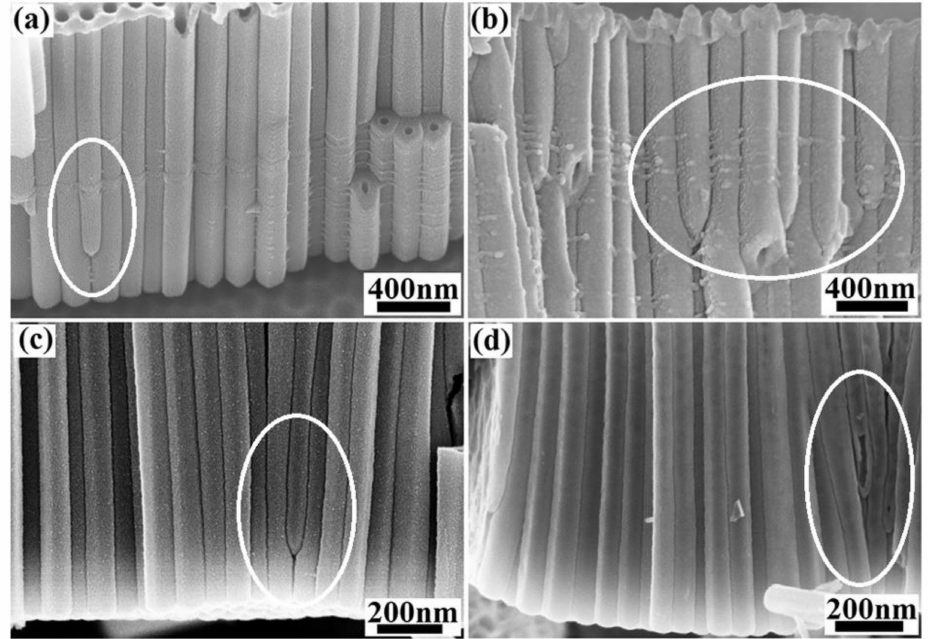
Figure 7. SEM images of terminated nanotubes obtained at different voltage, ( a ) 50 V, ( b ) 70 V, ( c ) 40 V and ( d ) 30 V. Reprinted with the permission from reference